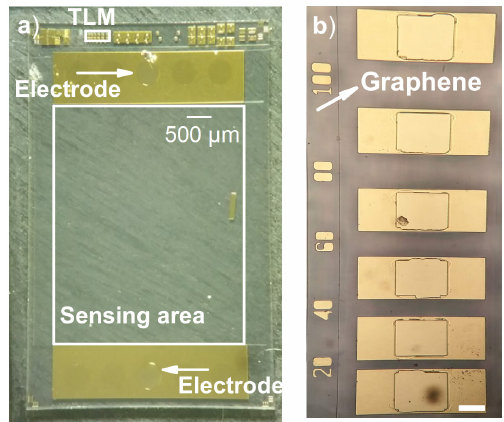
Figure 2. ( a ) Photograph of the graphene-based device, including marked transmission line measurements (TLM) structure. Below electrodes on each side of the device, openings were etched to the SiC substrate before metal deposition, causing the metal contacts to be anchored to the SiC substrate. Except for the middle opening (i.e., electrodes) on each side of the device and the active sensing area, passivation was performed with SU-8; ( b ) closeup of the TLM structure where contacts are separated at different lengths ranging from 20 µ m to 100 µ m, scale bar of 50 µ